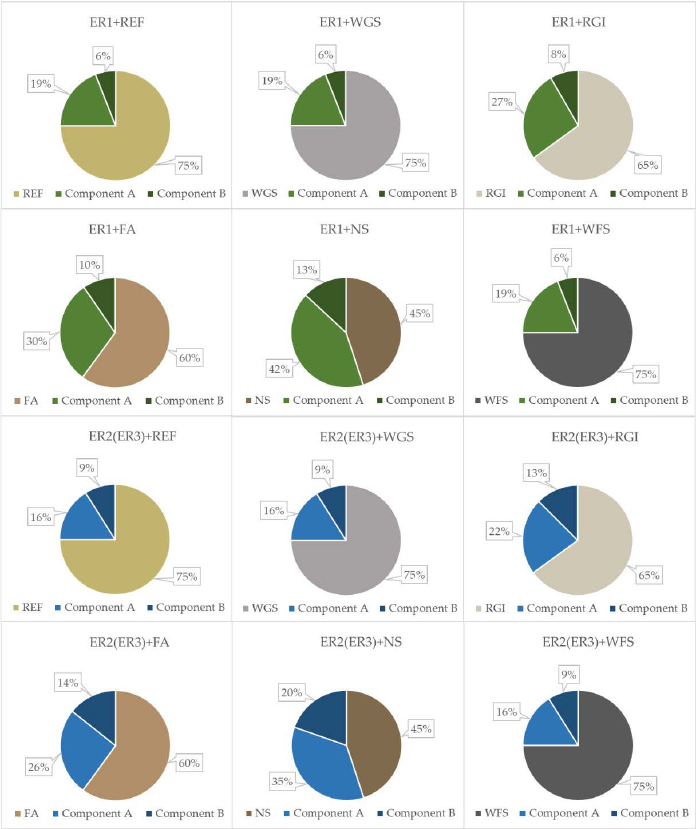
Figure 2. Tested formulations of the epoxy composites (ER—Epoxy resin, REF—Reference filler, WGS—Waste glass from solar panels, RGI—Waste from the production of mineral insulation boards, FA—Fly ash, NS—Neutralisation sludge, WFS—Waste foundry sand) .